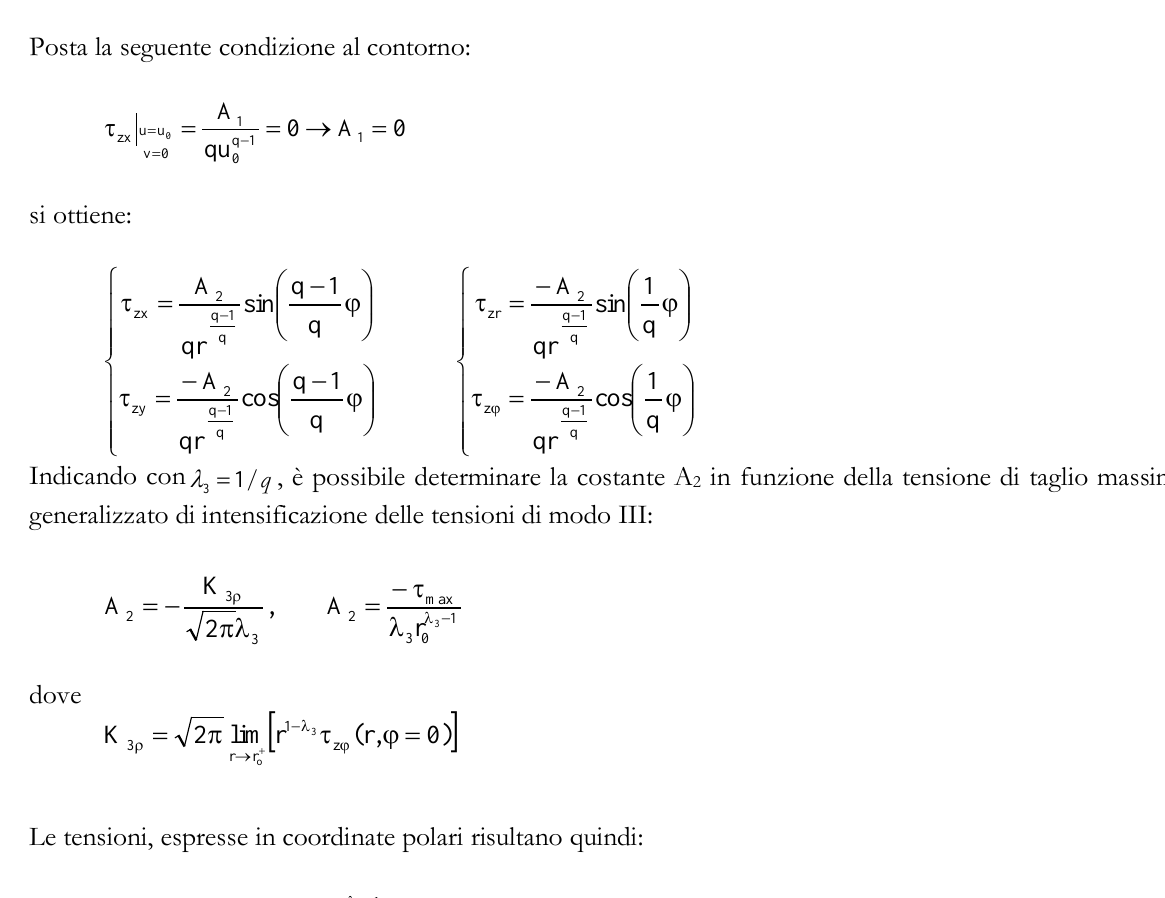
Figura 9: (a) Sistema di coordinate curvilinee ( u , v ); (b) sistema di riferimento adottato per la